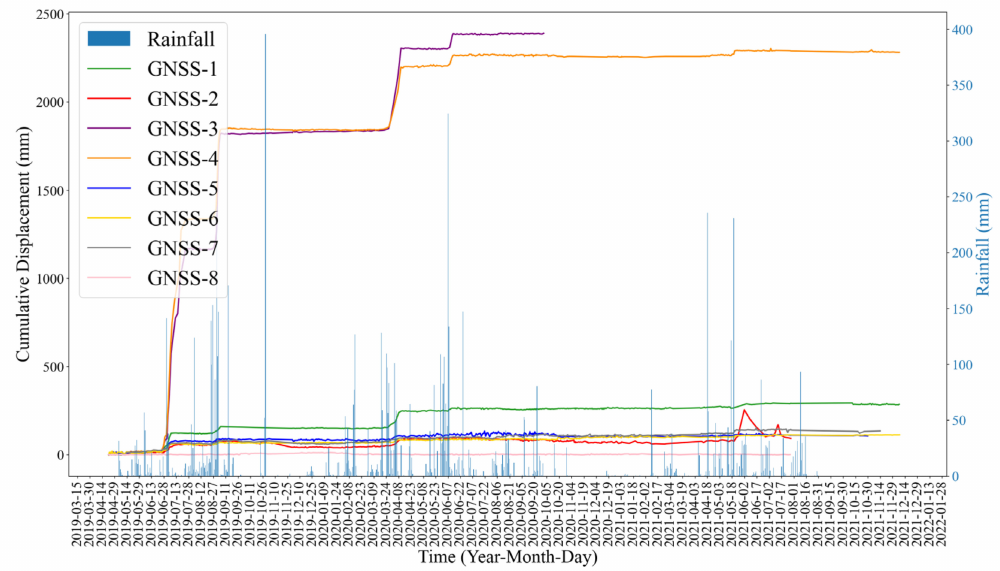
Figure 5. Deformation data and rainfall data of the Zhongma